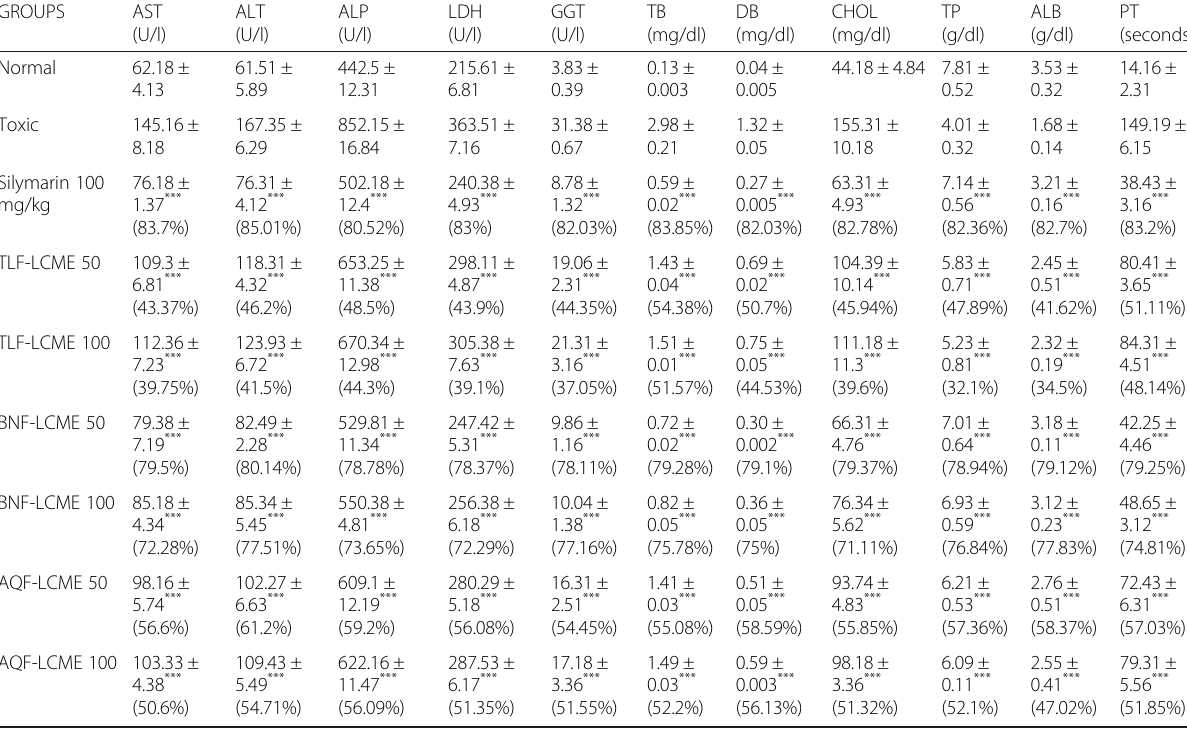
Table 3 Effect of methanolic extract fractions of LCME on different serum biochemical parameters in paracetamol induced hepatotoxicity in rats